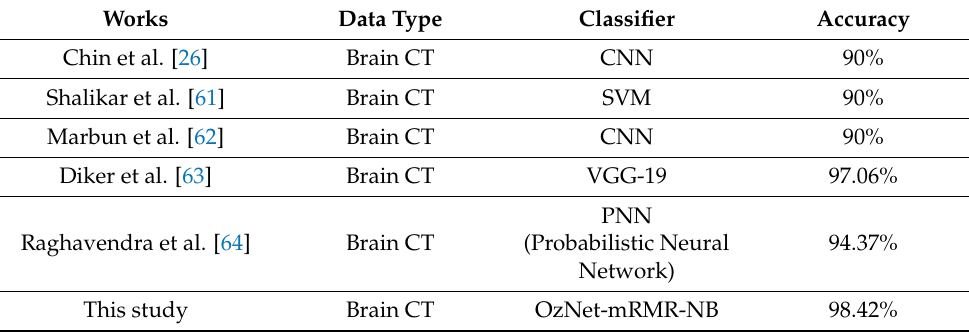
Table 6. Performance comparison with prior